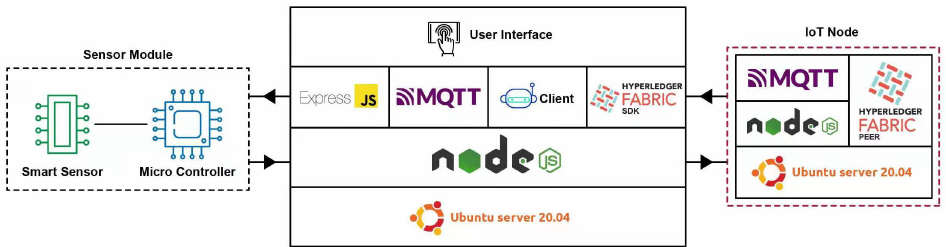
Figure 11. Application Node Architecture.